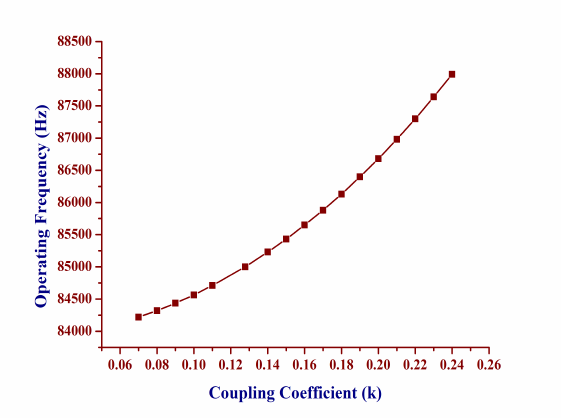
Figure 13. Operating frequency corresponding to coupling